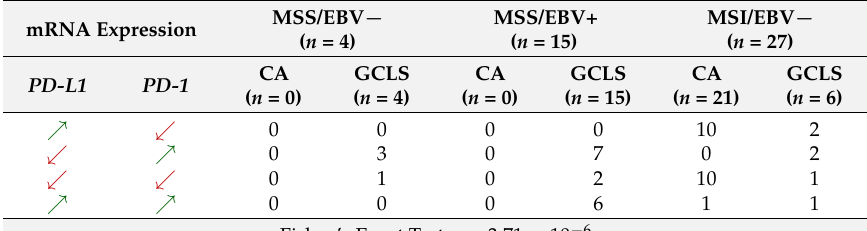
Table 8. Contingency table for the number of MSS/EBV − or MSS/EBV+ or MSI/EBV − cases with morphological features of GCLS or CA for the four PD-L1/PD-1 mRNA expression scenarios.